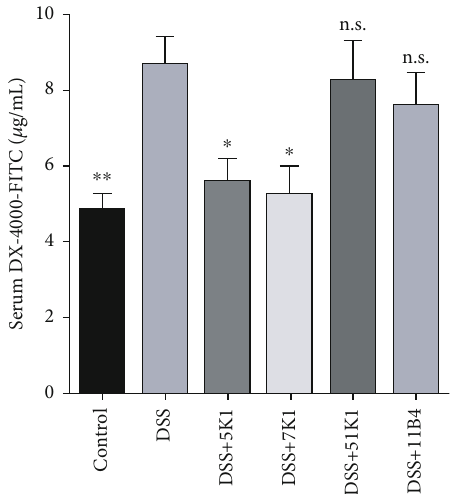
Figure 3: E ff ects of Bacteroides vulgatus on the intestinal permeability of mice. Four mice per